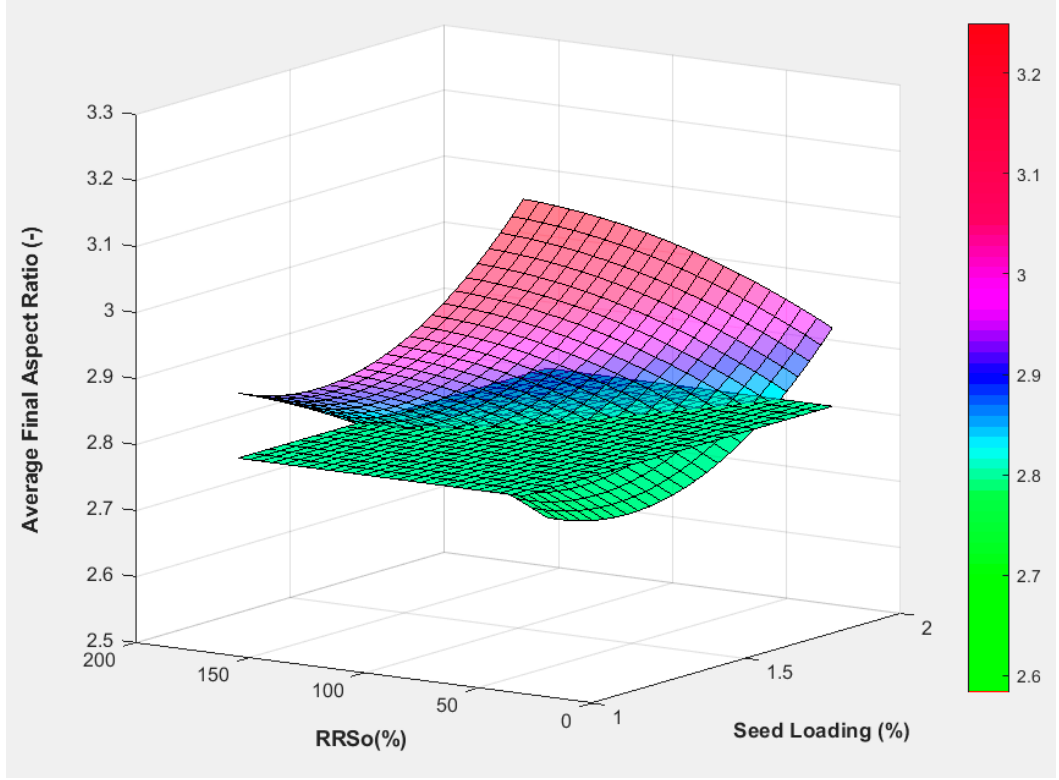
Figure 7. The model’s predictions for the final aspect ratio.